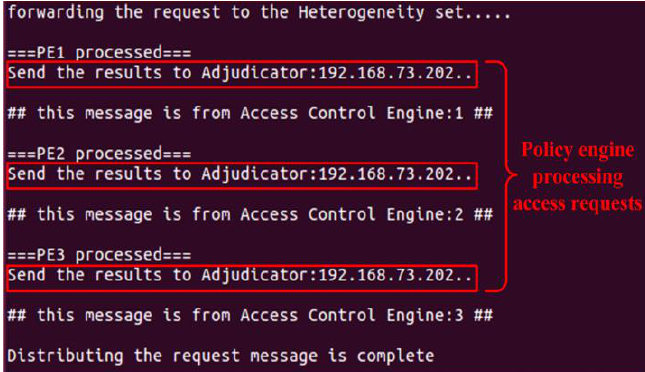
Figure 14. Request distribution.